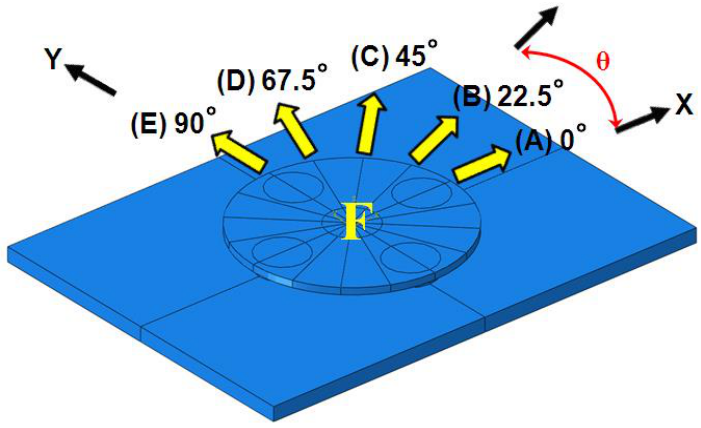
Figure 4. ( A ) Maximum strain change under 1-N directional tangential loading against principal strain variation in the + x direction (ε direction (ε yy